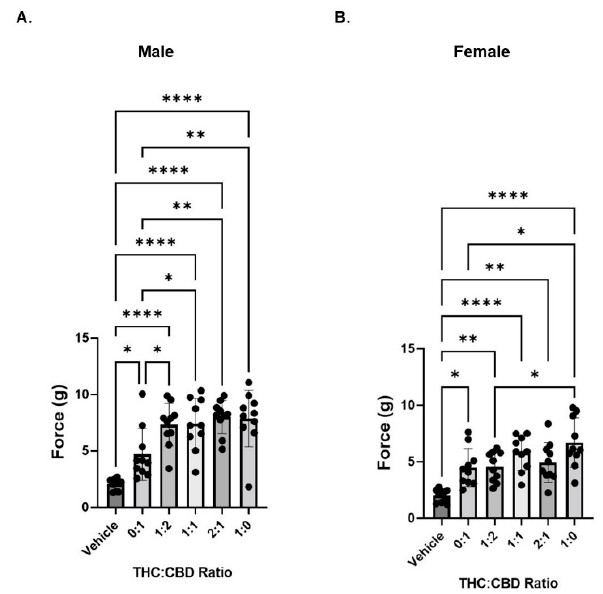
Figure 3. Cannabinoid extracts containing either CBD or THC reduce mechanical sensitivity in neuropathic mice. ( A ) Neuropathic male mice were treated with 6 mg/kg of total cannabinoid at varying ratios of THC:CBD and mechanical sensitivity was measured by von Frey filament. ( B ) Same as panel A except in female neuropathic mice. n = 10 mice per group. * p < 0.05, ** p < 0.01, **** p < 0.001.